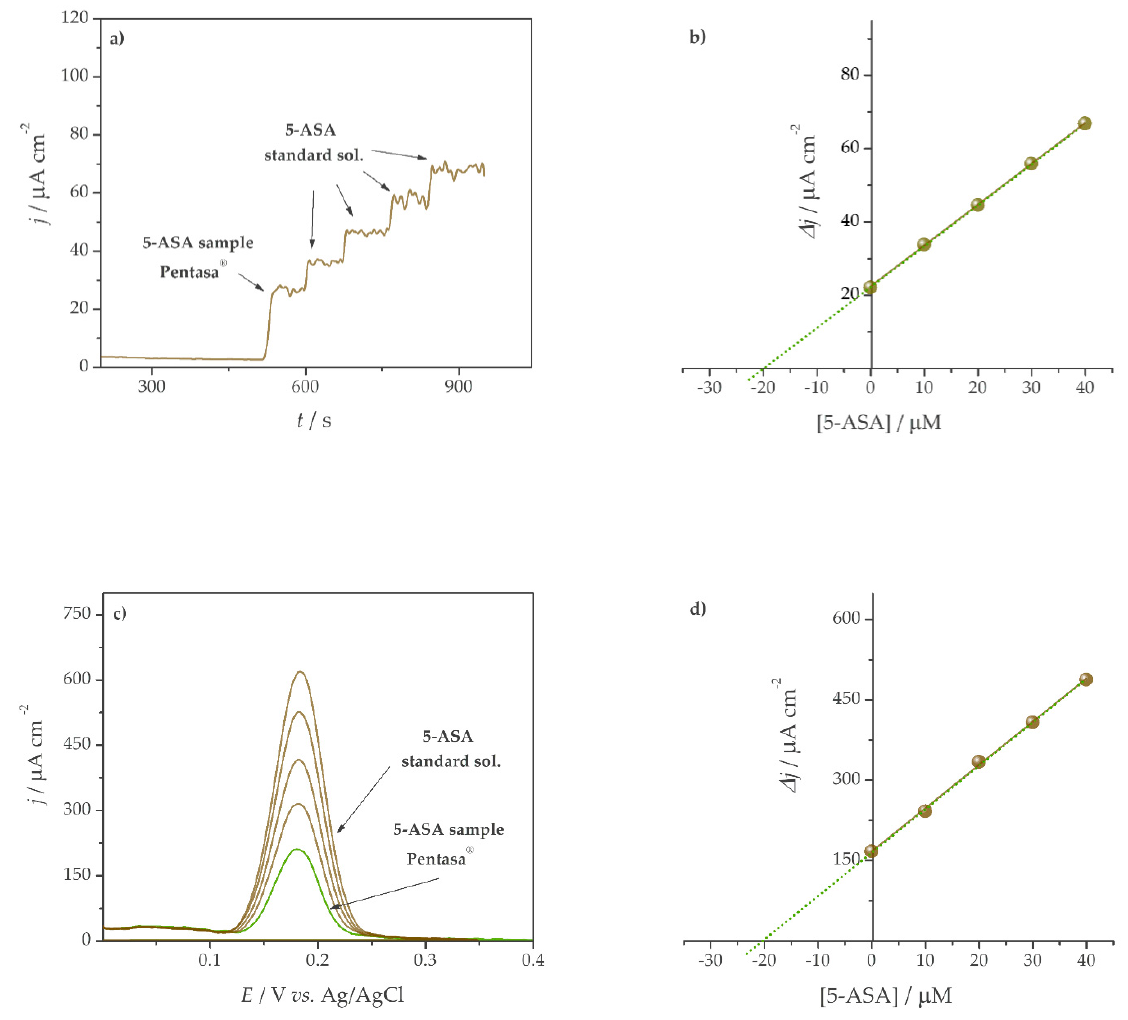
Figure 7. ( a ) CA response ( E app = + 0.40 V vs. Ag/AgCl) and ( c ) DPVs measurements ( v = 4 mV s − 1 , step potential 2 mV, pulse amplitude 50 mV) with CNT/PMB DES /GCE in 0.04 M BR pH 7.0 for 5-ASA analyzed from pharmaceutical samples (Pentasa ® tablets); ( b , d ) The corresponding calibration plots. Table 2. Determination of 5-ASA in pharmaceutical formulations.